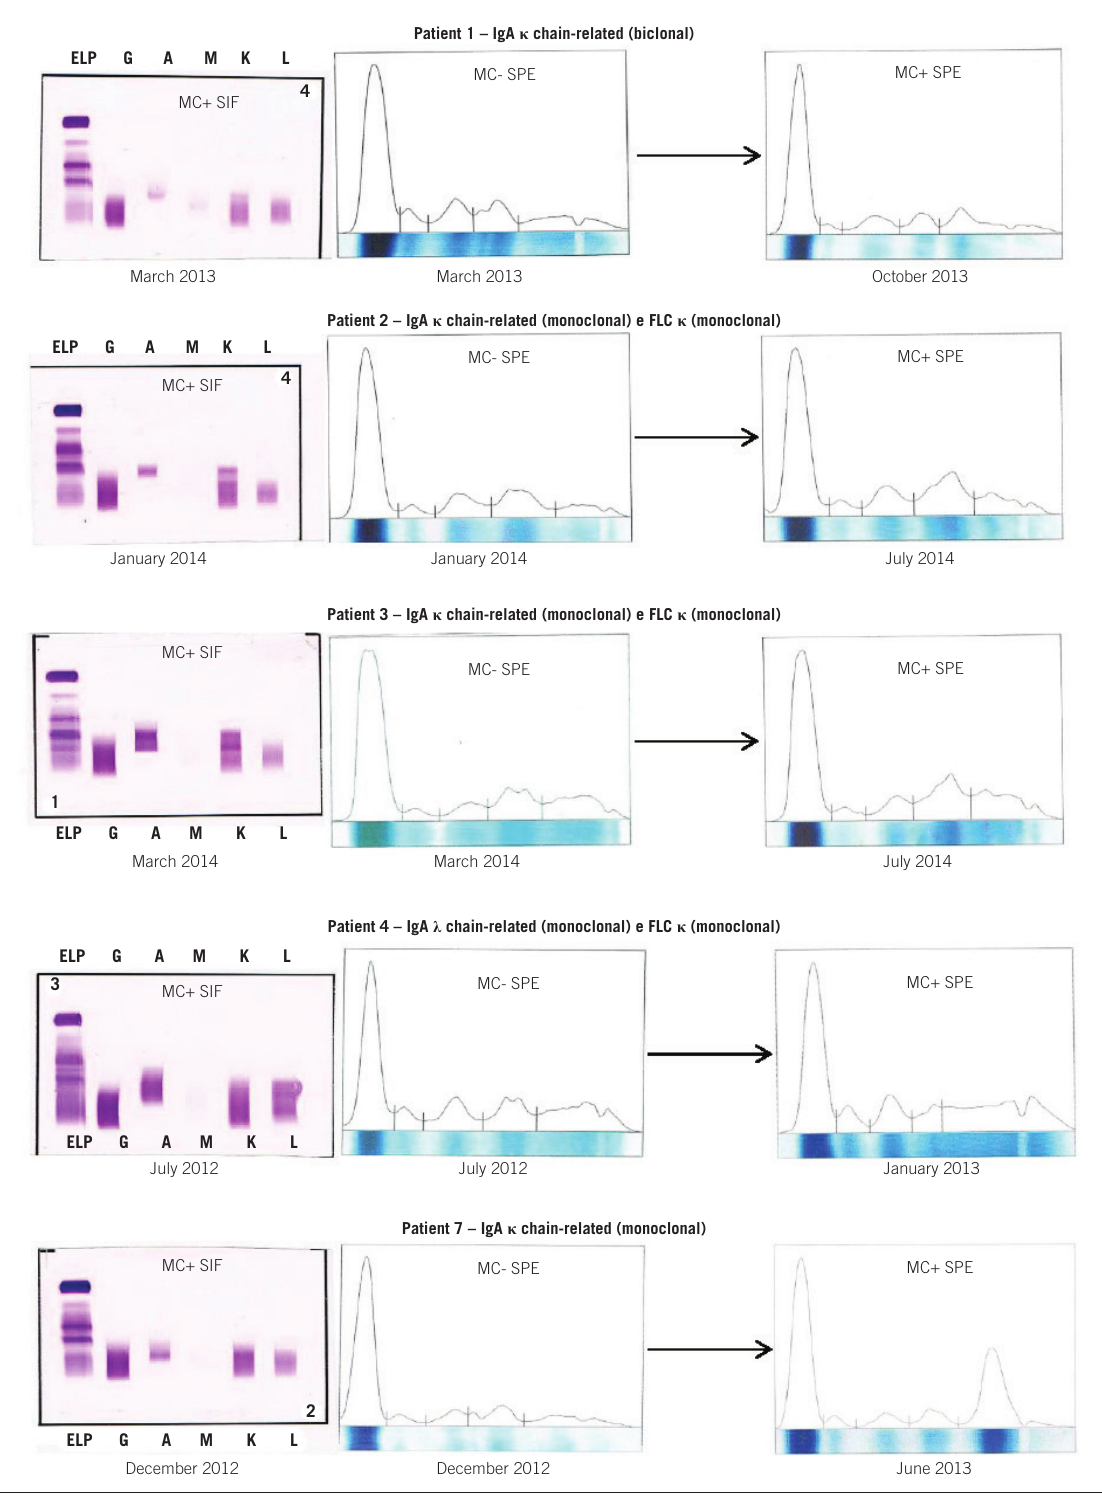
figuRE 2 − Comparative images between SIF and SPE in serum proteins analysis to detect mono/biclonal components in patients 1, 2, 3, 4, and 7, with the same IgA component, at different moments MC+ and MC- indicate the presence and absence of mono/biclonal components,